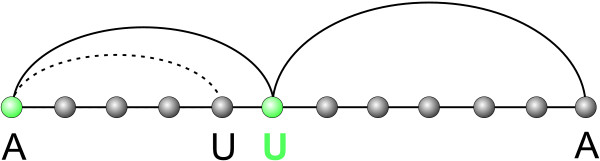
Inconsistent structures. The dotted arc is perturbed by shifting its end-point. This perturbation leads to a nucleotide establishing two base pairs, which is impossible.